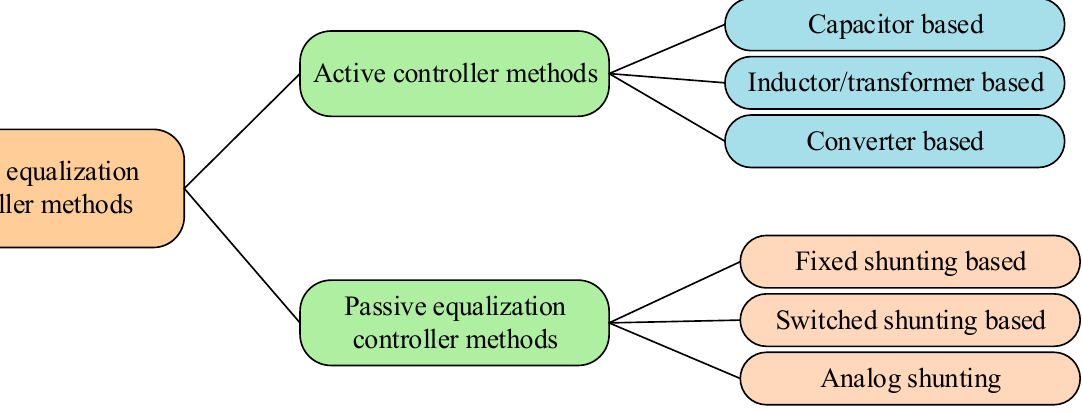
Figure 6. Charge equalization controllers for lithium-ion batteries. The active charge equalization controller (CEC) works on the principle of transferring energy from cell to cell, cell to battery pack, or battery pack to cell [110]. The excess energy is collected from overcharged cell and delivered to the undercharged cell to equalize the charge and voltage. The active CEC can also be categorized into three types, namely, capacitor-based, inductor/transformer-based, and converter based. The energy transfer from cell to heat via a shunting resistor is the basic hypothesis of passive CEC, which can be distinguished into fixed shunting, switched shunting, and analog shunting. A fixed resistor is used in the fixed shunting method to bypass the current flows and control the voltage. Similarly, a controllable switch (relay) bypasses the release path from the overcharged battery in the switched shunting method. The most effective method among the three is the analog shunting method which uses a transistor instead of a resistor to complete the task of the current bypass from high-energy cells [109]. A constant current string-to-cell battery equalizer with open-loop current control was proposed by Wei et al. [111], as depicted in Figure